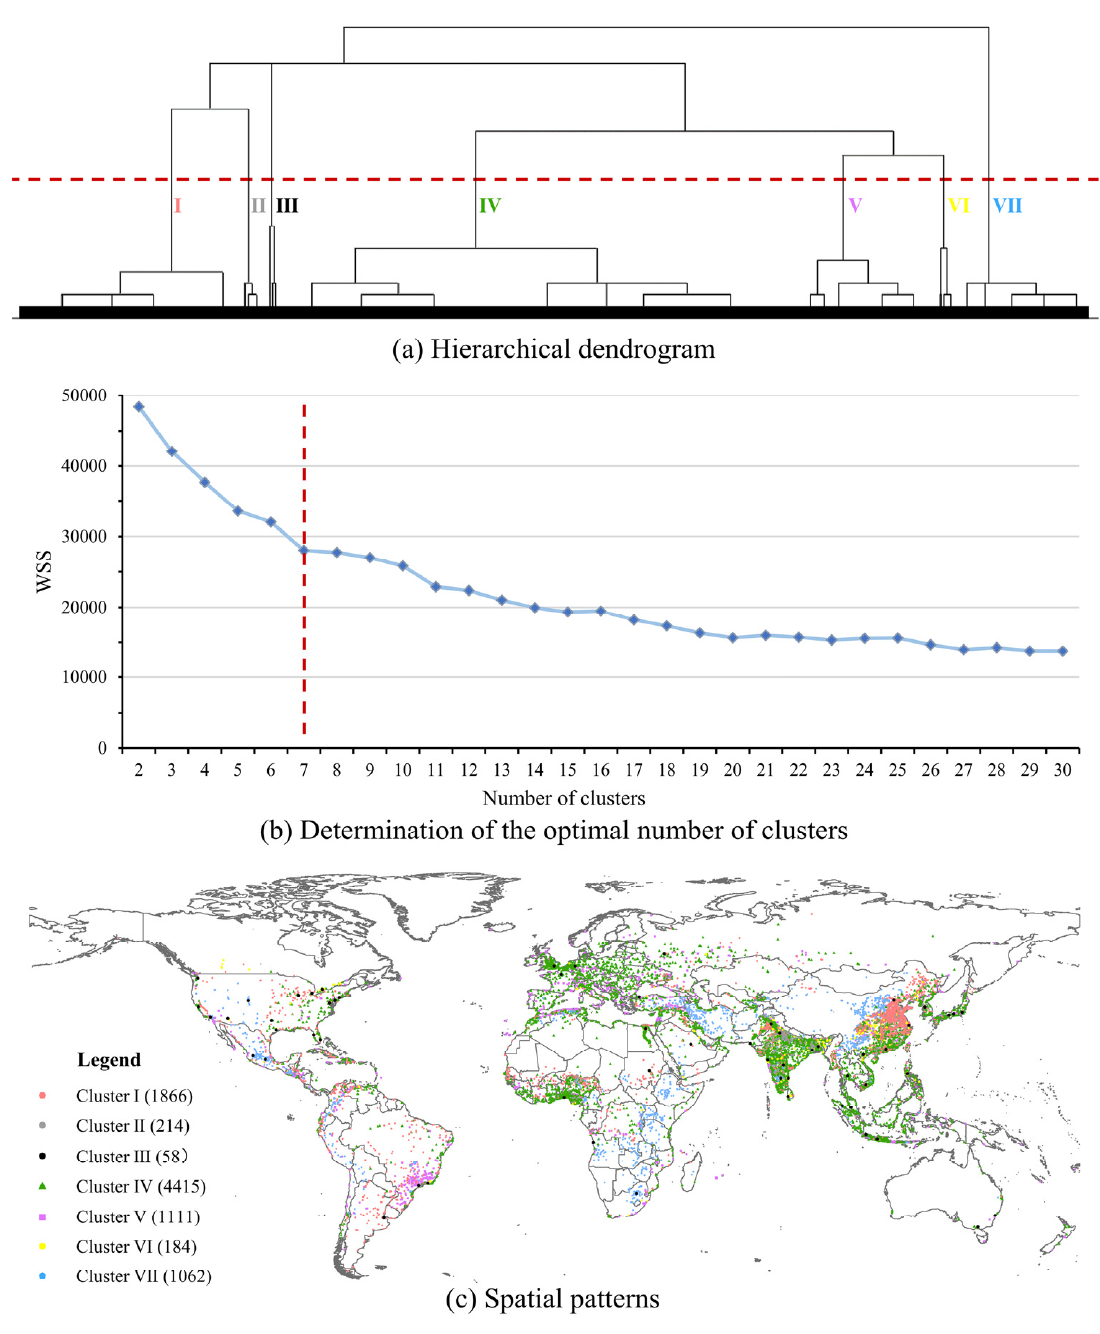
Figure 2. A hierarchical clustering of global urban street networks based on six PCs.